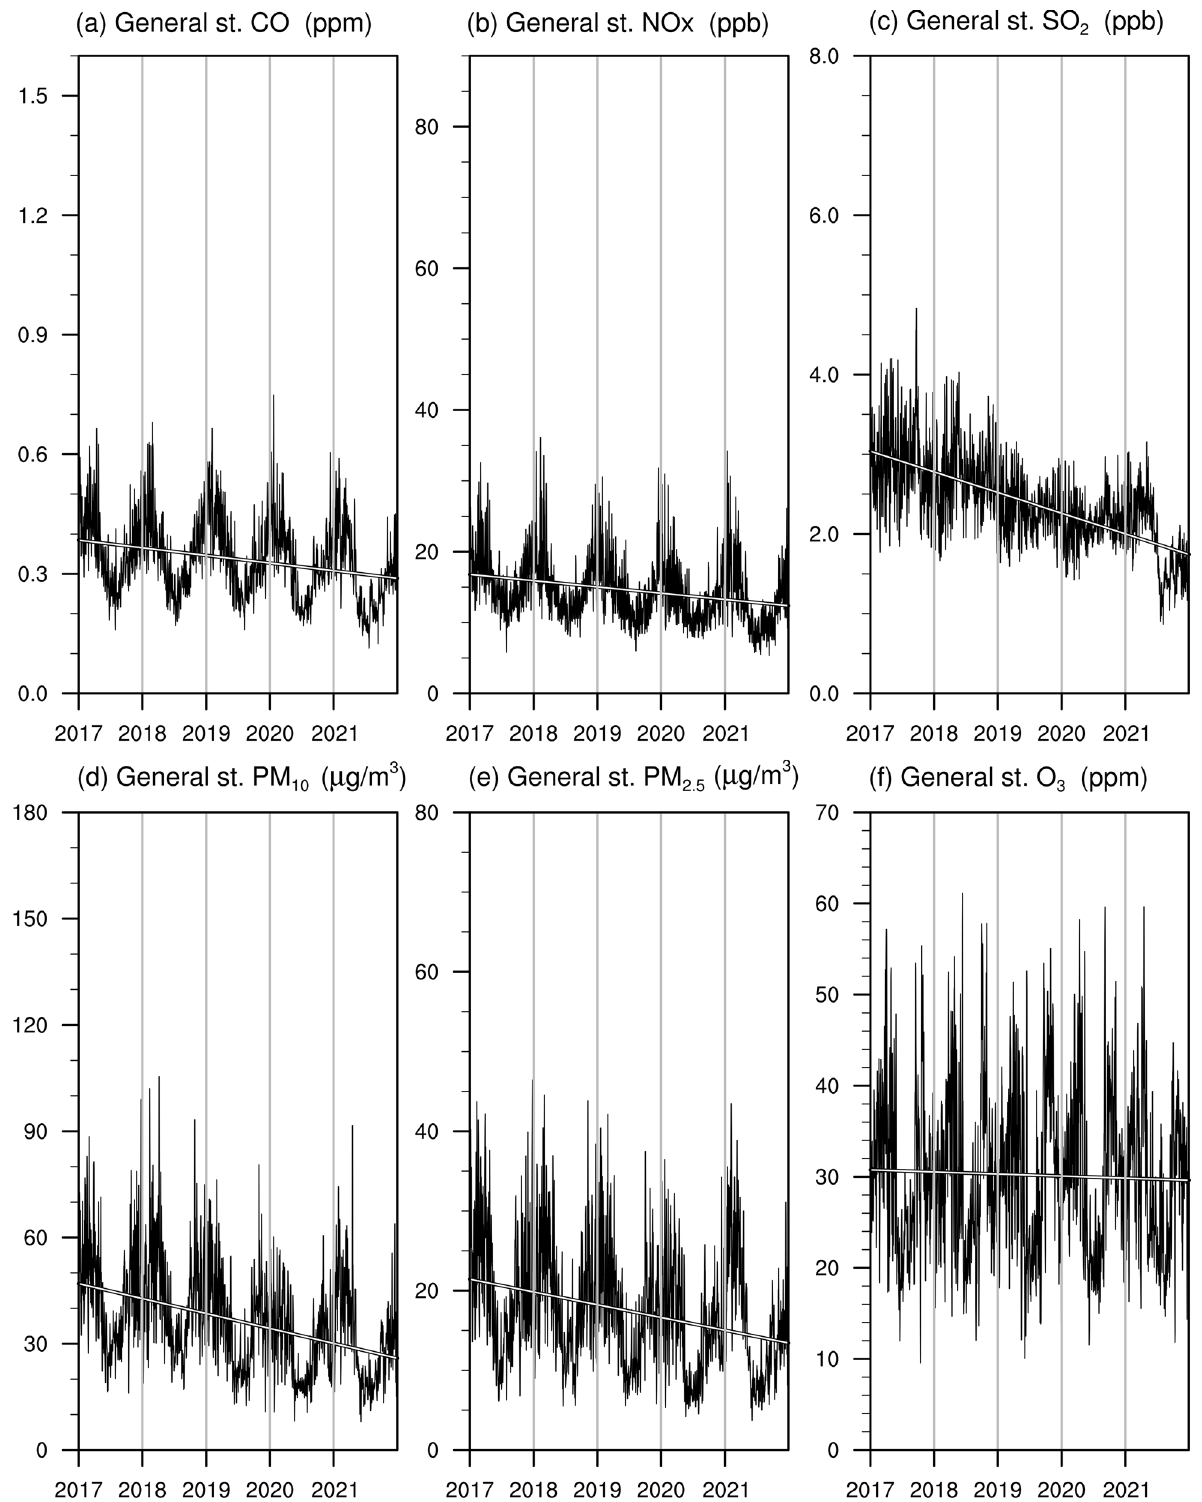
Fig. 4 Variations of daily ( a) CO, ( b) NO x , ( c) SO 2 , ( d) PM 10 , ( e) PM 2.5 , ( f) O 3 concentration (black line) monitored by the general stations with a trend over the years from 2017 to 2021 (gray